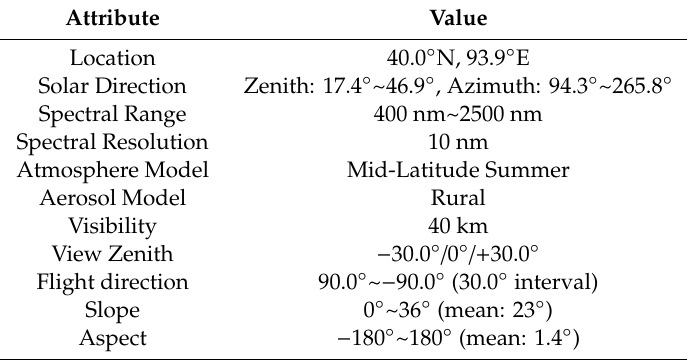
Figure 7. The simulated radiance of the overlap area, ( a ) the image acquired from 60 ◦ flight direction and − 30 ◦ zenith; ( b ) the image acquired on 60 ◦ flight direction and + 30 ◦ zenith. Table 3. Simulation Parameters for composite slope digital simulation experiment.